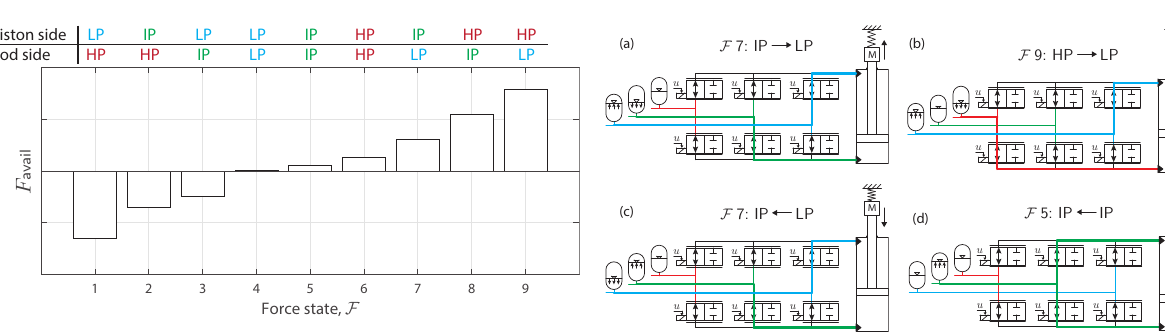
Figure 4: Simplified operation scenarios against a spring